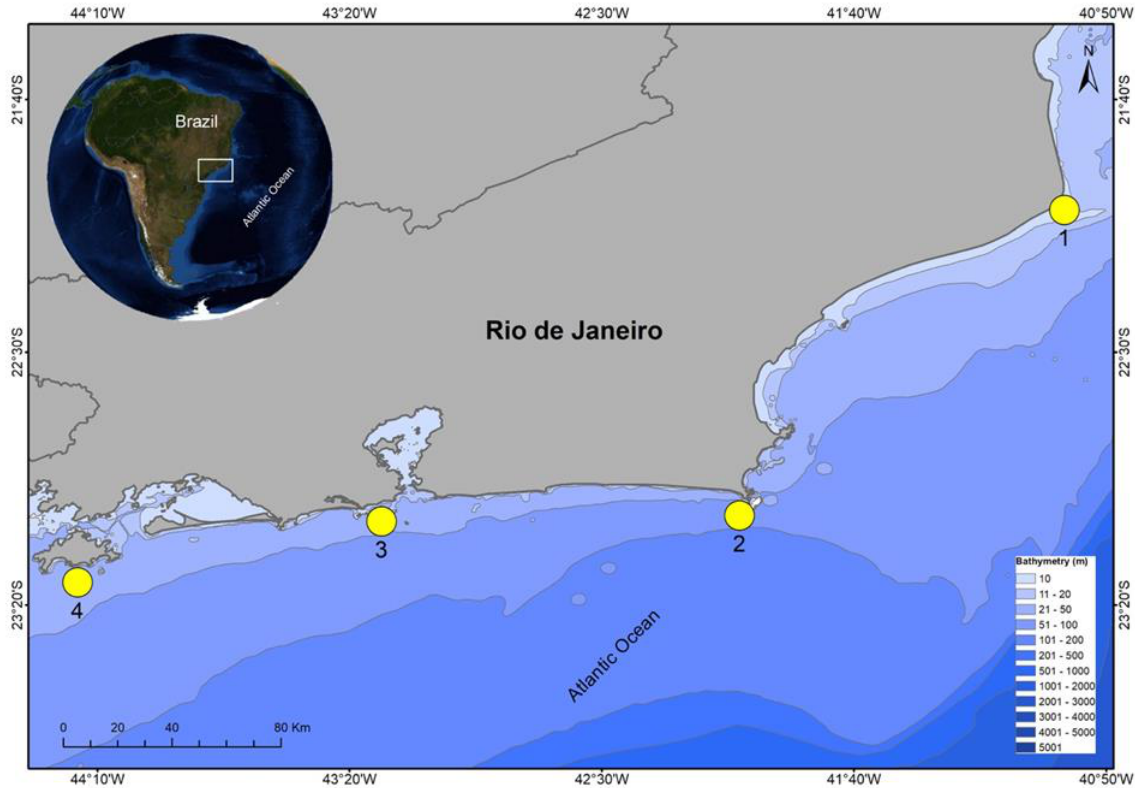
Figure 1. Map indicating the four information sampling regions on Galeocerdo cuvier occurrences in the state of Rio de Janeiro, Southeastern Brazil. 1 — Norte Fluminense region, 2 — Baixada Litorânea region, 3 — Metropolitan region and 4 — Ilha Grande Bay region.